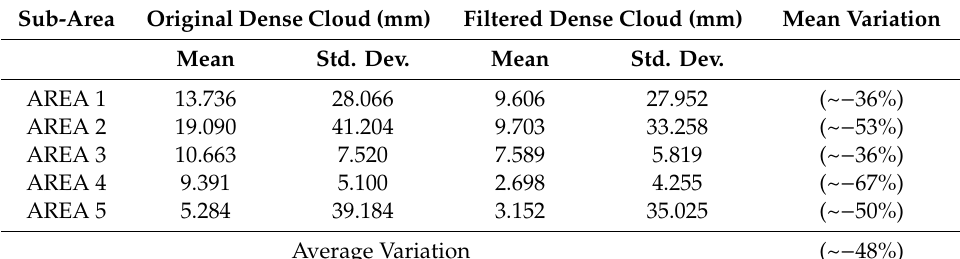
Table 17. Results of the cloud-to-cloud distance analyses on the original and filtered dense clouds and average variation of the mean